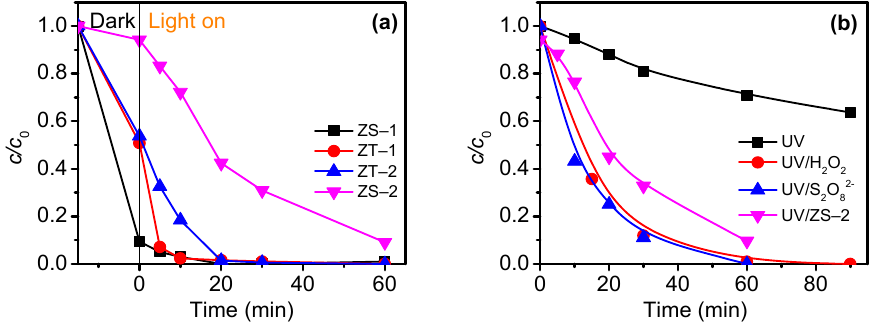
Figure 6. Efficiency of FB 1 (1.39 μ mol/dm 3 ) removal at pH ~8 using ( a ) different nanocrystallites (1 mg/cm 3 ) during UV photocatalysis; ( b ) photolysis and photocatalysis by UV